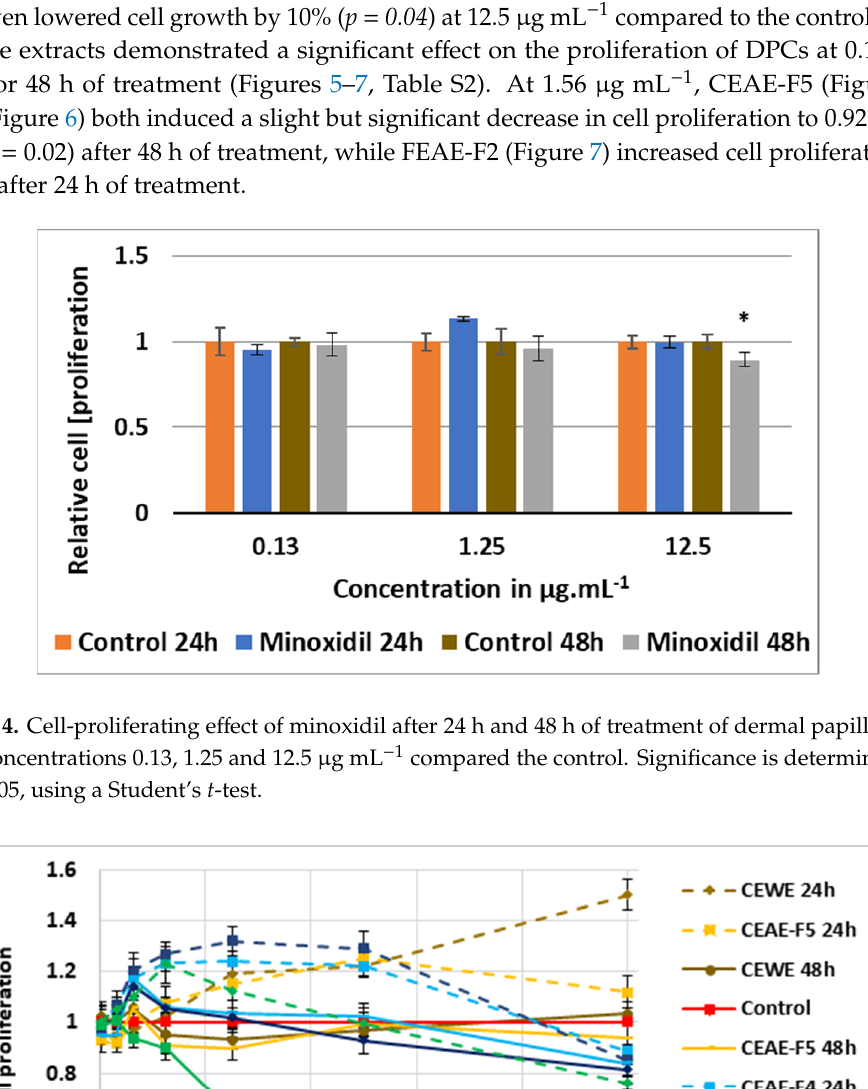
Figure 6. Cell proliferating effect of B. pilosa ethyl acetate extract (BEAE) and resulting fractions BEAE- F3 and BEAE-F4 after 24 h and 48 h of treatment of dermal papilla cells with concentrations 0.1 to 50 µg.mL −1 normalized and compared the control. Error bars represent SEM. The 24-h treatment revealed that between 3.13 µg.mL −1 and 25 µg.mL −1 , all extracts showed either comparable cell viability to that of the control or induced significant cell proliferation. Furthermore, CEAE induced a dose-dependent proliferative effect on DPCs between 3.13 µg.mL −1 and 12.5 µg.mL −1 , with a 20% ( p = 0.035), 27% ( p = 0.0004) and 32% ( p = 0.02) increase at 3.13, 6.25 and 12.5 µg.mL −1 , respectively (Figure 5). This dynamic was seen at higher concentrations for CEWE, FEAE, FEAE-F0 and FEAE-F3 (Figure 7) with a cell proliferation increase ranging between 21% and 25% (0.016 ≤ p- value ≤ 0.04) at 25 µg.mL −1 to an increase between 31% and 50% (0.003 ≤ p- value ≤ 0.05 ) at 50 µg.mL −1 . Only CEAE-F3 at 50 µg.mL −1 was toxic to cells as it caused a 24% decrease ( p = 0.004) in viability compared to the control, thus dipping below 80% cell viability.